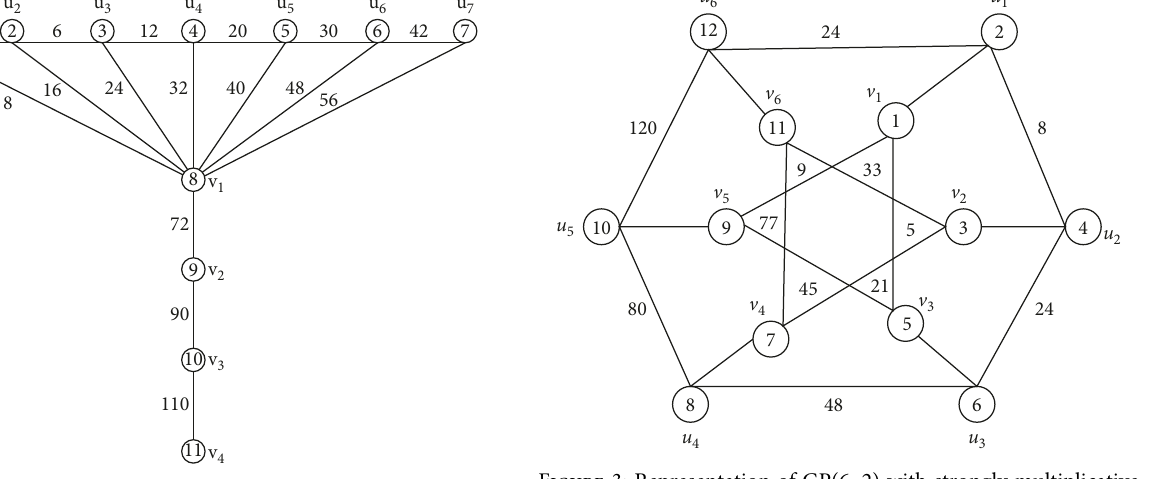
Figure 2: Representation of U ( 7 , 4 ) with strongly multiplicative labeling.